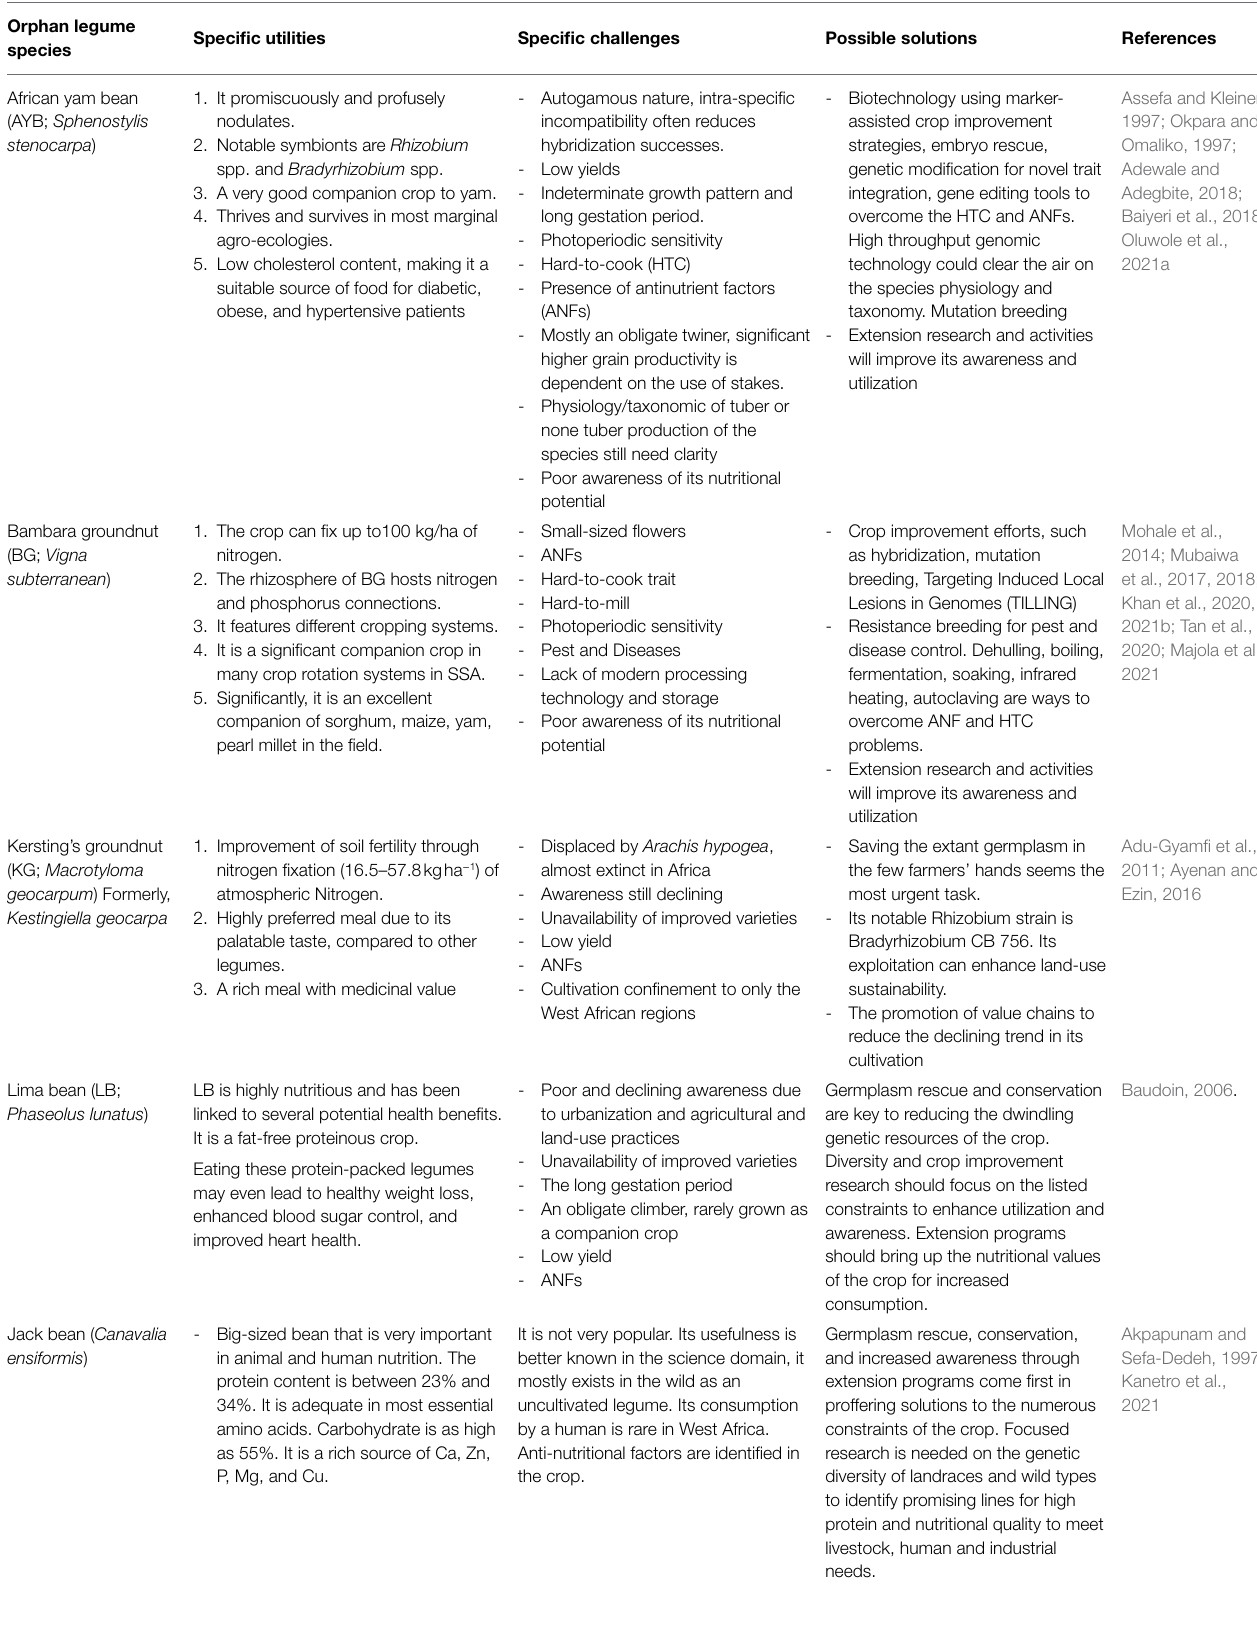
TABLE 4 | Agronomic Utilities, Challenges, and plausible solutions of the five orphan legumes. Orphan legume